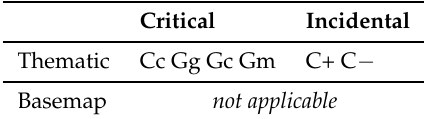
Table 5. Schedule of operators for Gapminder